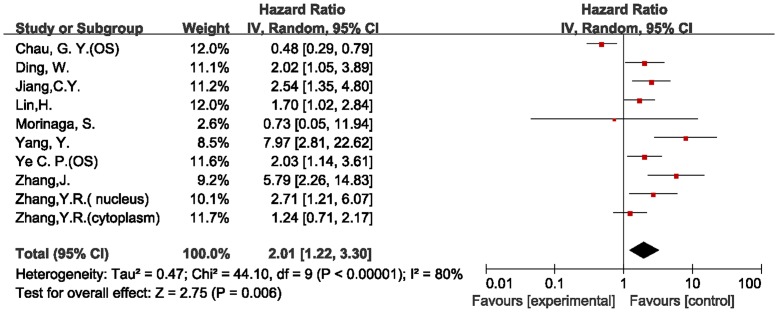
Forest plot of Hazard ratio (HR) for overall survival (OS) of HCC patients.Highly significant heterogeneity can be found before Chau GY’ study was excluded.